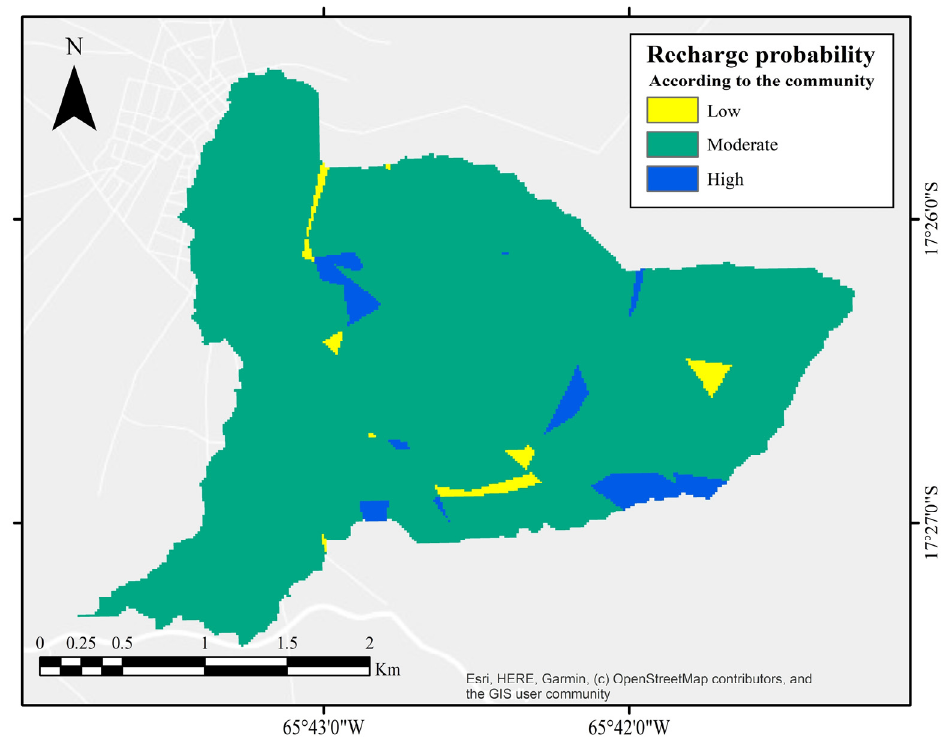
Figure 12. Groundwater recharge probability according to the community members of Virvini.